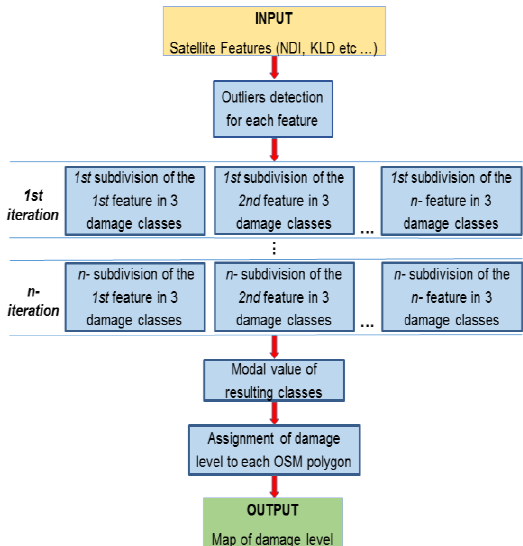
Figure 2: FST method block scheme